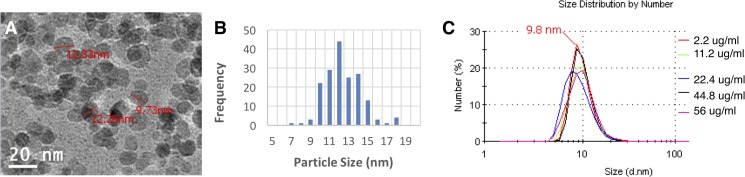
SPION characterization.A section of the TEM image of SPIONs after 20 times dilution in pure water (A). A histogram was obtained by particle size analysis of 172 particles on the TEM image using NIH ImageJ software (B). The size distribution of SPIONs in pure water at varying concentrations (2.2, 11.2, 22.4, 44.8, 56 μg/mL) was measured by using ZetaSizer® Nano ZS at 22°C (C).